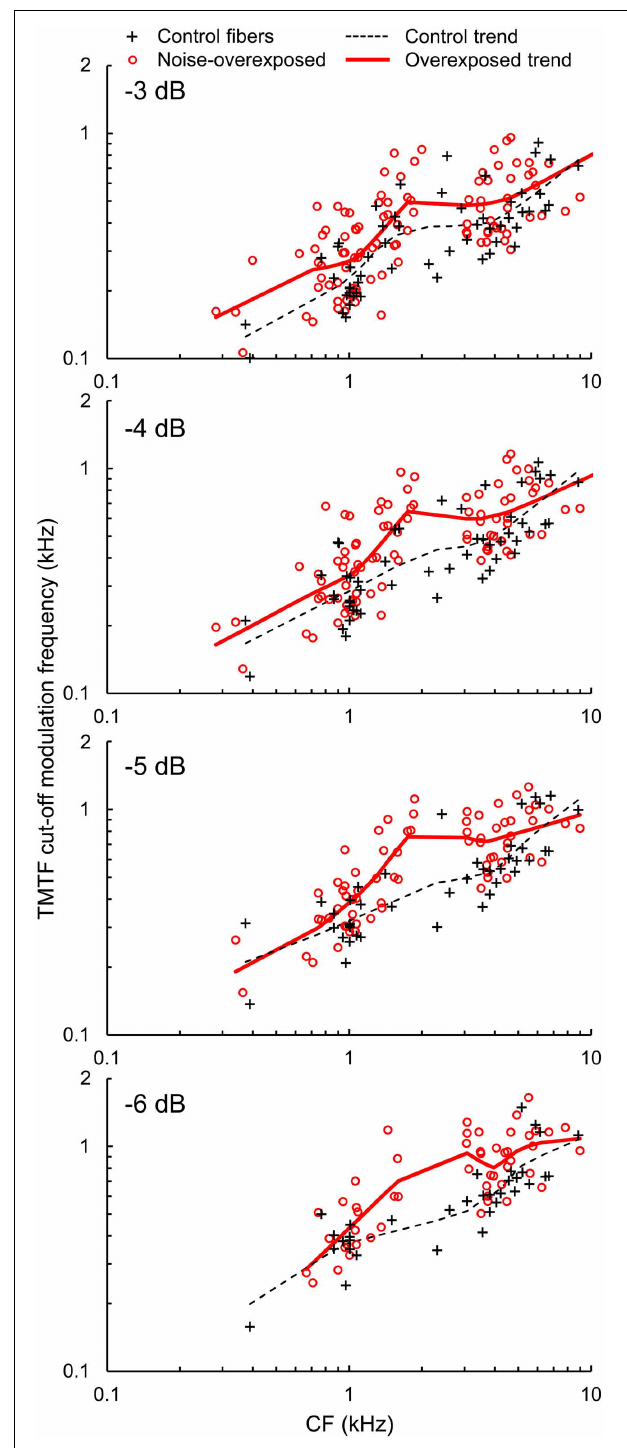
FIGURE 6 | TMTF cut-off modulation frequencies. Cut-off modulation frequencies measured 3, 4, 5, and 6dB down from the peak of the TMTF plotted as a function of CF in normal hearing and noise-overexposed fibers. Modulation cut-offs in dB are marked at the top left of each panel, and trend lines are based on local regression analyses. Cut-off modulation frequencies were 20–25% greater in noise-overexposed fibers than in normal-hearing